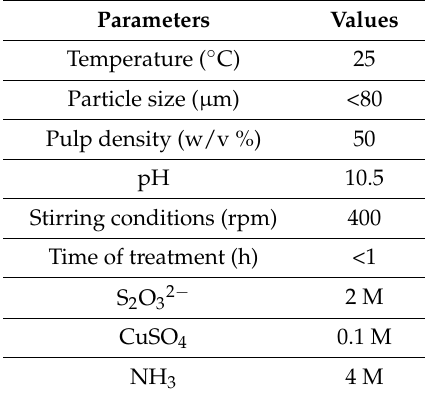
Table 3. Best process parameters of the gold leaching.